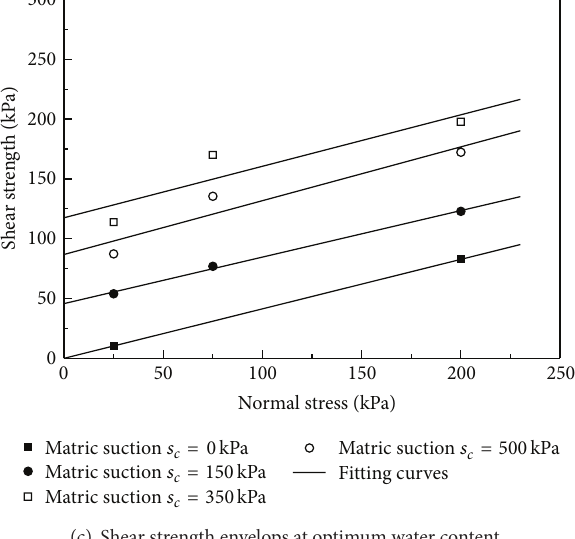
Figure 2: The curves of normal stress and shear strength at different initial water content state of soil (experimental data from Vanapalli et al.